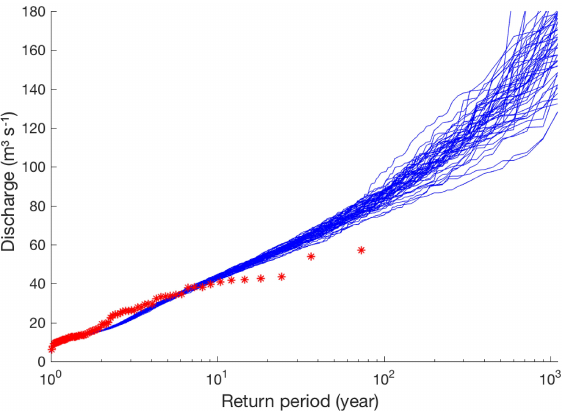
Figure 16. Comparison between the empirical return periods of an- nual extremes of the observed and simulated discharge for case 3 based on 50 time series of 3600 years of rainfall and corresponding